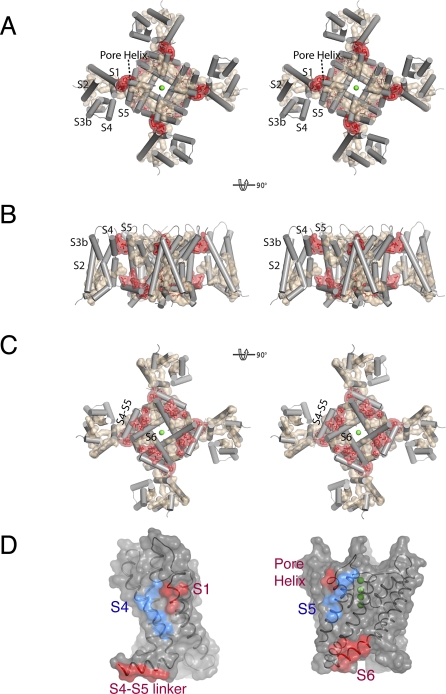
Mapping SCA-Derived, Co-Evolved Residues onto the Structure of the Paddle Chimera (PDB ID: 2R9R)The co-evolved residues identified in Figure 1D are shown in van der Waals surface (light brown). K+ ions are shown as green spheres. Stereo-views of the paddle chimera are shown in (A): looking from the extra-cellular side; in (B): from the side;, and in (C): from the intra-cellular side. The co-evolved residues form a structurally connected network where the inner membrane leaflet part of the voltage sensor is coupled to the pore via the S4-S5 linker. The co-evolved residues that are involved in the interfaces between the voltage-sensor and the pore are shown in red in (A), (B), and (C).(D) Surface representations of the interfaces between the voltage sensor and the pore in the structure of the paddle chimera. Shown separately are the voltage sensor from a single subunit and the tetrameric pore domain. The contact surfaces corresponding to the co-evolved interfaces between the S1 and the pore helix and the S4-S5 linker and S6 are colored red. The contact surfaces between the S4 and S5 are colored blue. The contact surfaces comprise residues that are within 4.0 Å distance.